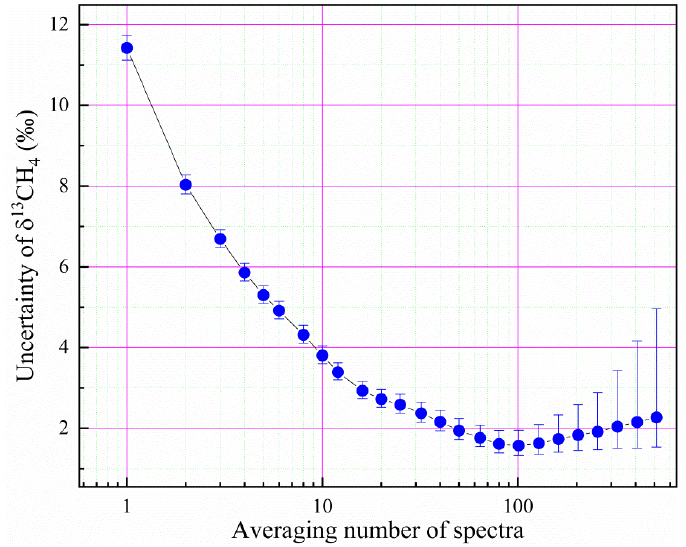
Figure 12. Allan variance analysis for the precision of CH 4 isotope measurements, together with indications of 95% confidence intervals.